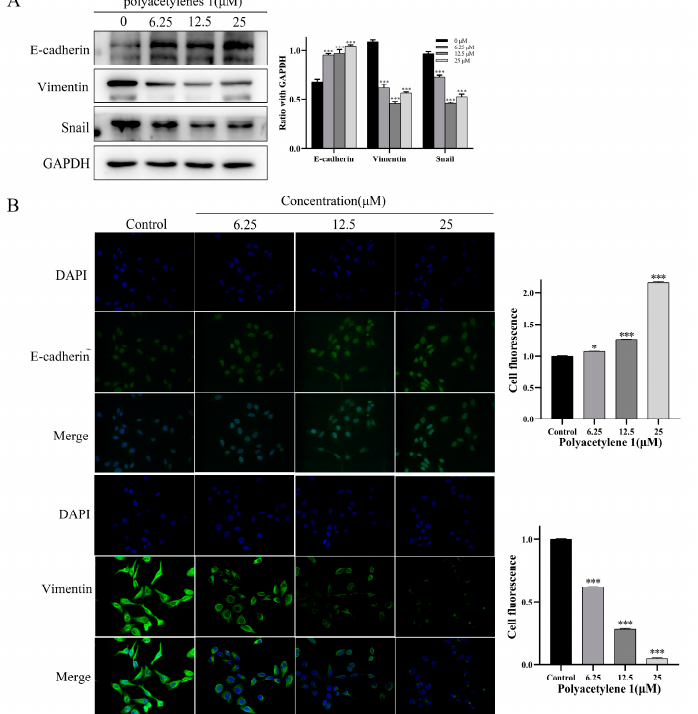
Figure 6. Effects of polyacetylene 1 on the EMT marker molecule protein in HGC-27 cells. ( A ) Effects on the expression of E-cadherin, Vimentin, and Snail in HGC-27 cells treated with 25, 12.5, and 6.25 µ M of polyacetylene 1 for 24 h. E-cadherin, Vimentin, and Snail were measured using the Western blotting method. GAPDH was used to ensure an equal amount of loaded protein. ( B ) Immunofluorescence images of E-cadherin and Vimentin in HGC-27 cells treated with 25, 12.5, and 6.25 µ M of polyacetylene 1 for 24 h. Nuclear counterstaining with DAPI is shown separately. Scale bars: 200 µm. Significant differences compared with the control group are designated as * p < 0.05 and *** p < 0.001. Results are expressed as the mean ± SEM (n = 3).